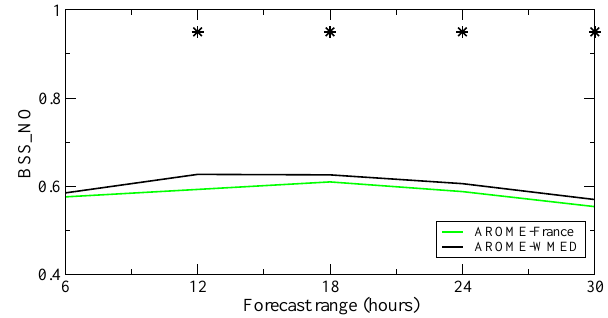
Figure 14. Brier skill score computed in a neighbouring distance of 54km for AROME-France (green) and AROME-WMED (black) for simulated 10.8µm SEVIRI brightness temperature lower than 240K during the SOP1 period from 05 September to 05 Novem- ber 2012. Stars represent the statistical significance of the difference between the two models, which is 90% for all forecast ranges above